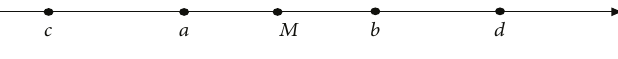
Figure 1: Position graph of x